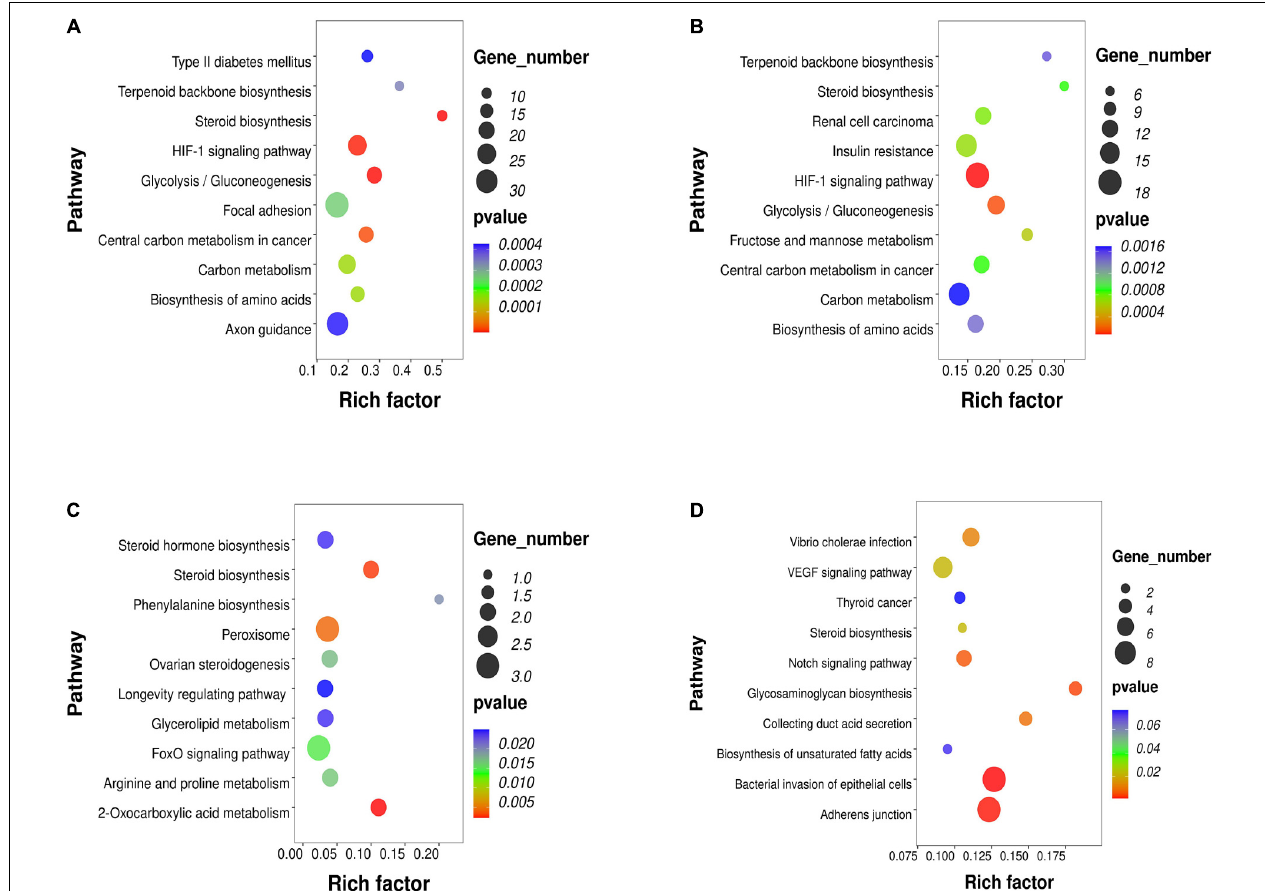
FIGURE 2 | KEGG pathway analysis of RNA-seq and methylation results in PCOS and control GCs. The top 10 affected biofunctions are grouped by disease. (A) Enriched KEGG pathways of DEGs. (B) Enriched KEGG pathways of DELs. (C) Enriched KEGG pathways of DEMs. (D) Enriched KEGG pathways of